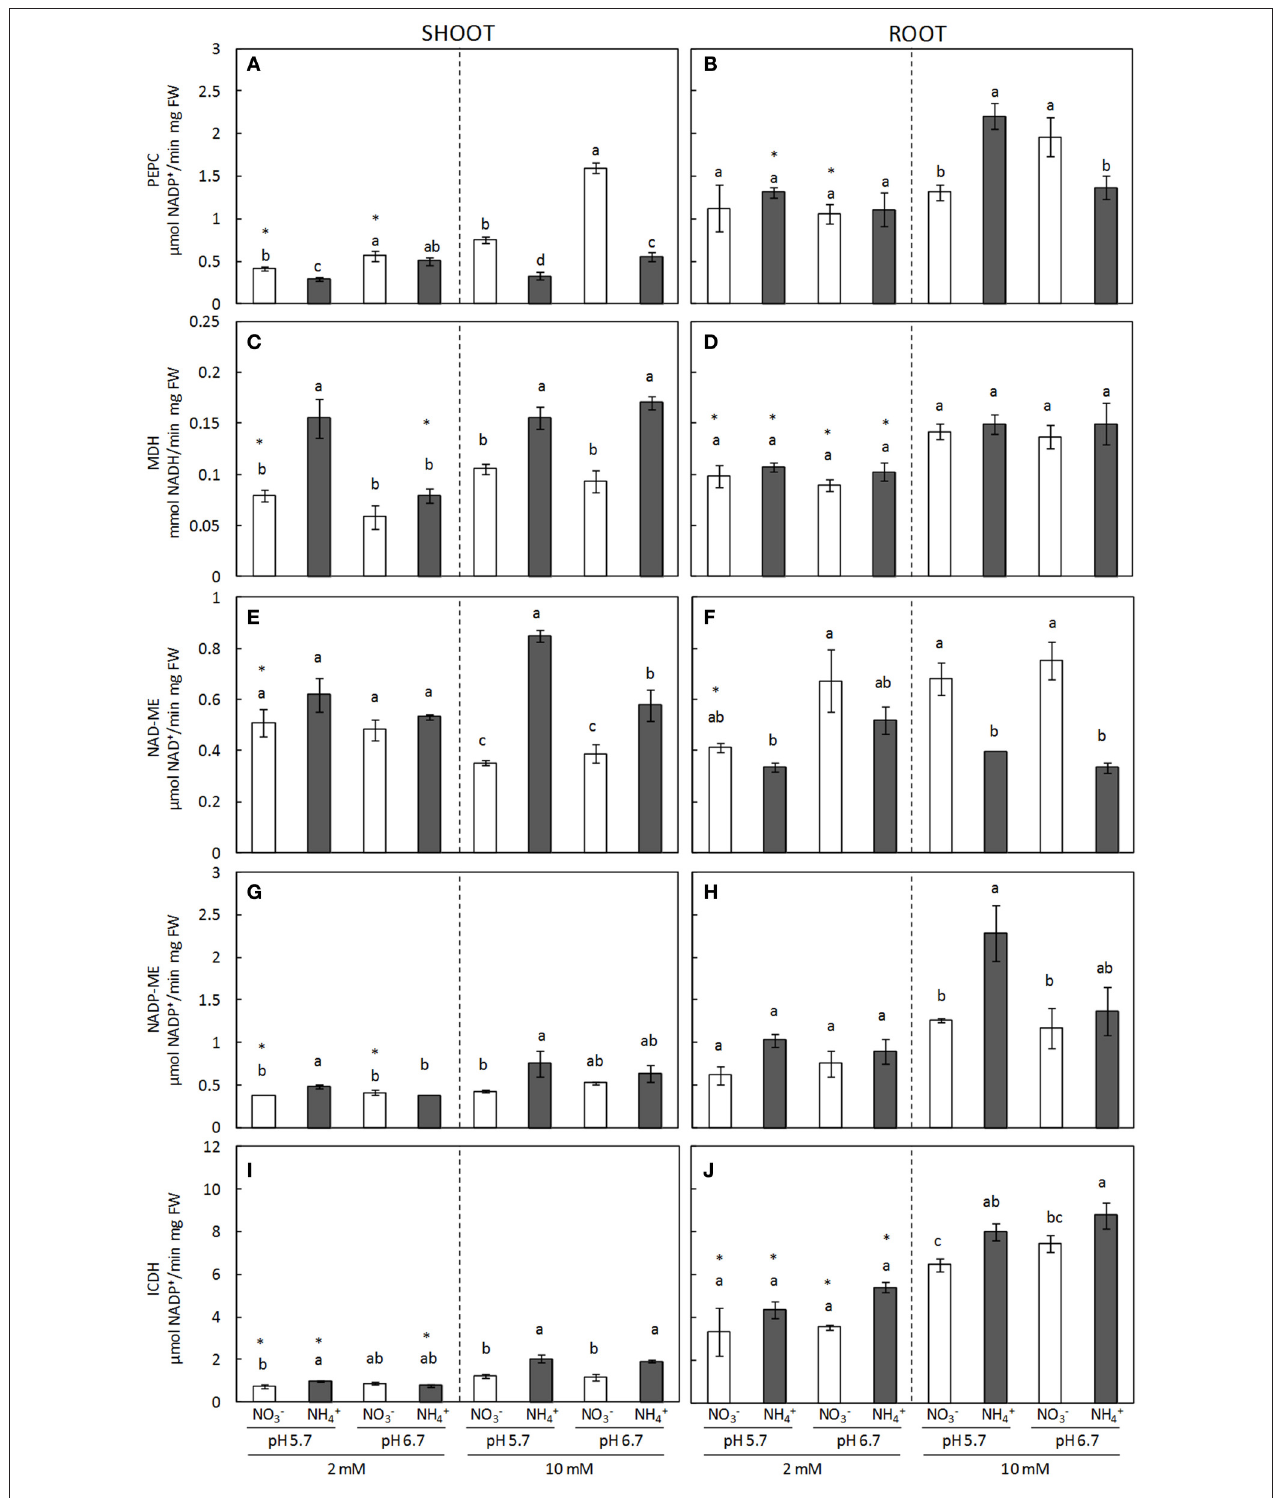
FIGURE 6 | PEPC (A,B), MDH (C,D), NAD-ME (E,F), and NADP-ME (G,H) and ICDH (I,J) enzyme activities from shoots (A,C,E,G,I) and roots (B,D,E,H,J) of plants grown under different conditions of pH (5.7 or 6.7), N source (NO − 3 or NH + 4 ) and concentration (2 or 10mM). Statistical analysis was described in Figure 1 . Columns represent mean ± se ( n = 3 –6). Each sample is a pool of three plants.